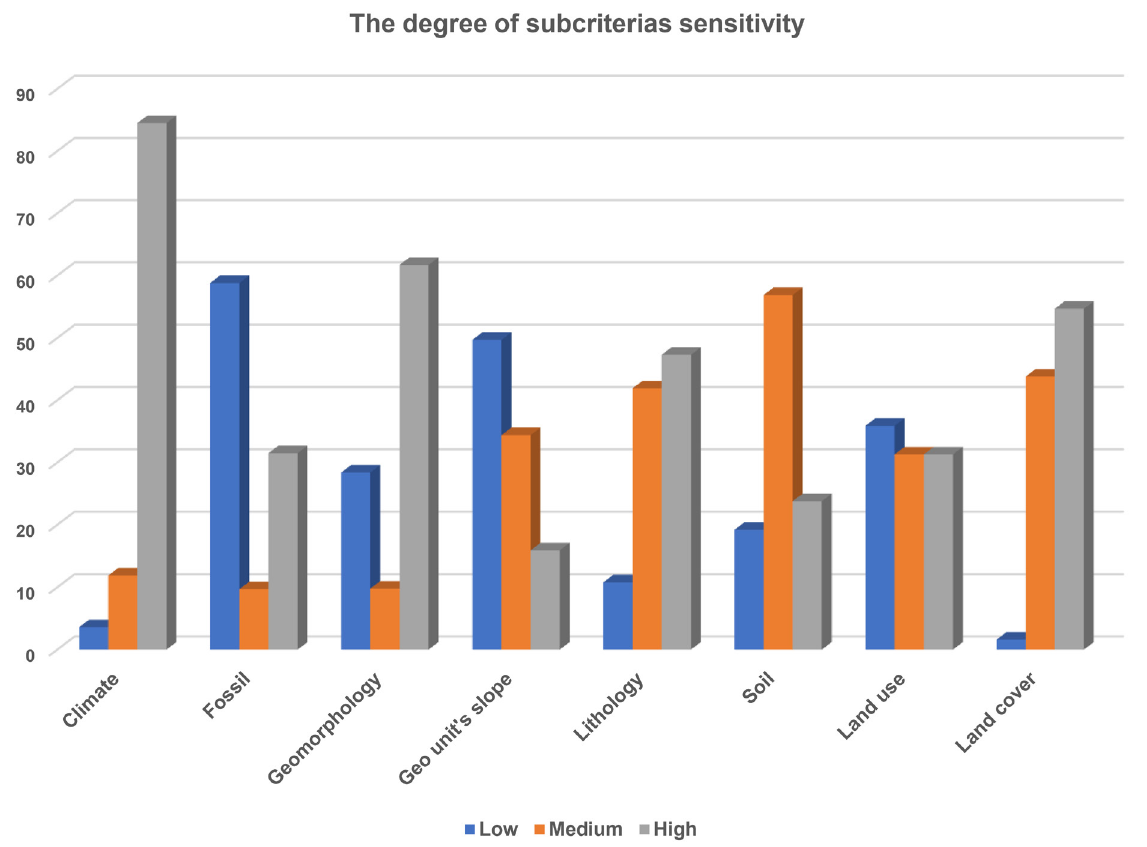
Figure 8. Sensitivity metrics for each of the sub-criteria (high sensitivity is equivalent to low geodiversity and low